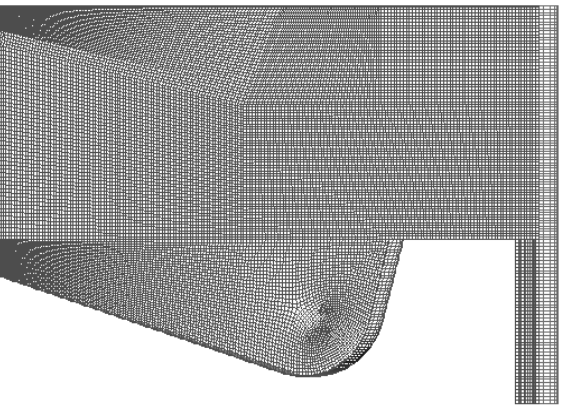
Figure 4. Engine combustion chamber geometry.